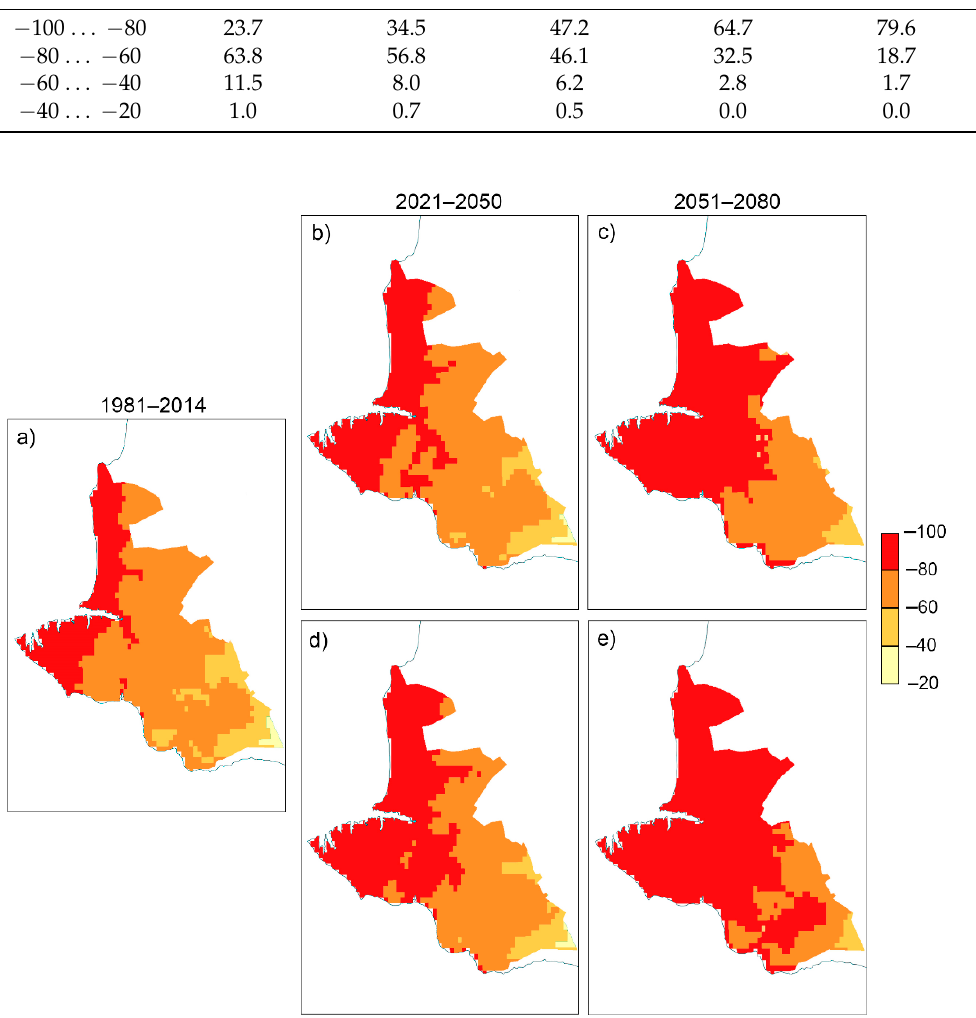
Figure 6. Spatial distribution of the dryness index (mm) in the Sevastopol region for the base period ( a ) and the expected changes at SSP2-4.5 ( b , c ) and SSP5-8.5 ( d , e ) for future periods.